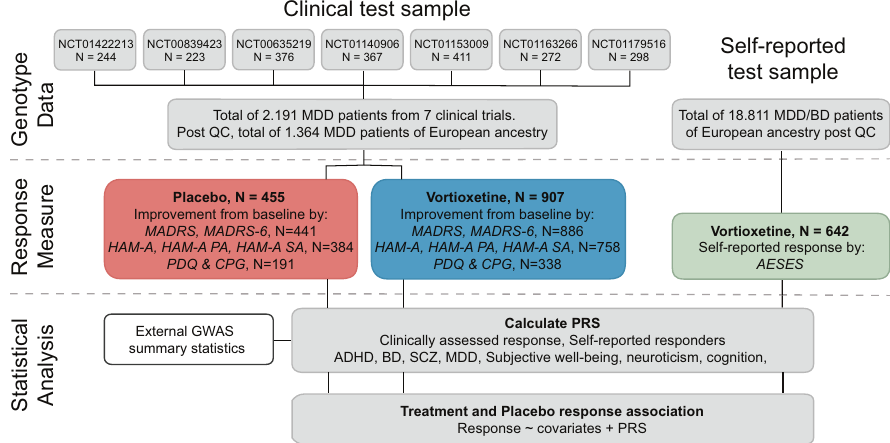
Fig. 1 Overview of the samples and study design. The clinical test sample included 2191 genotyped MDD patients treated with vortioxetine or placebo from 7 randomized, double-blind, placebo-controlled clinical trials. 907 vortioxetine-treated patients and 455 placebo-treated patients of European genetic ancestry passed genotyping quality control (QC). Response was quanti fi ed using different clinical scales and sub- scales, resulting in 6 response measures for both the vortioxetine and the placebo group. The self-reported test sample of European ancestry participants suffering from depression or bipolar disorder identi fi ed 642 vortioxetine-treated participants based on the AESES questionnaire. In the statistical analysis, PRSs for treatment response, diseases, and symptom traits were calculated for everyone in both samples. Vortioxetine and placebo response association with these PRSs were